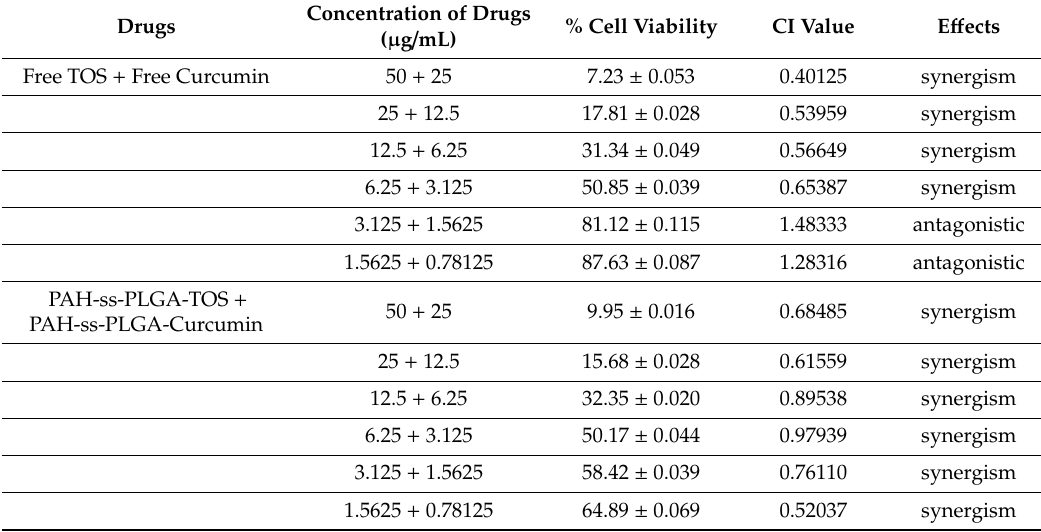
Table 2. E ff ects of combined TOS and curcumin treatment on PAN02 pancreatic cancer cells. CI: combination